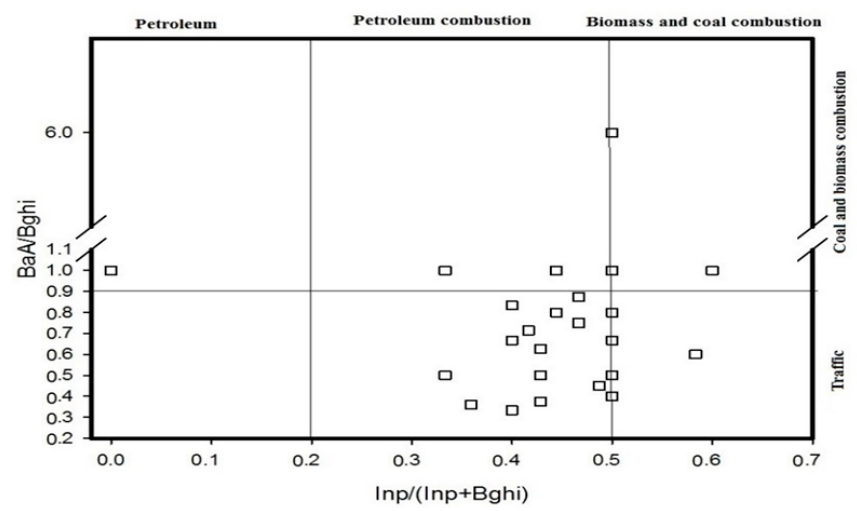
Figure 6. Source identifications of PAHs in soils of the Momoge Wetland (2).